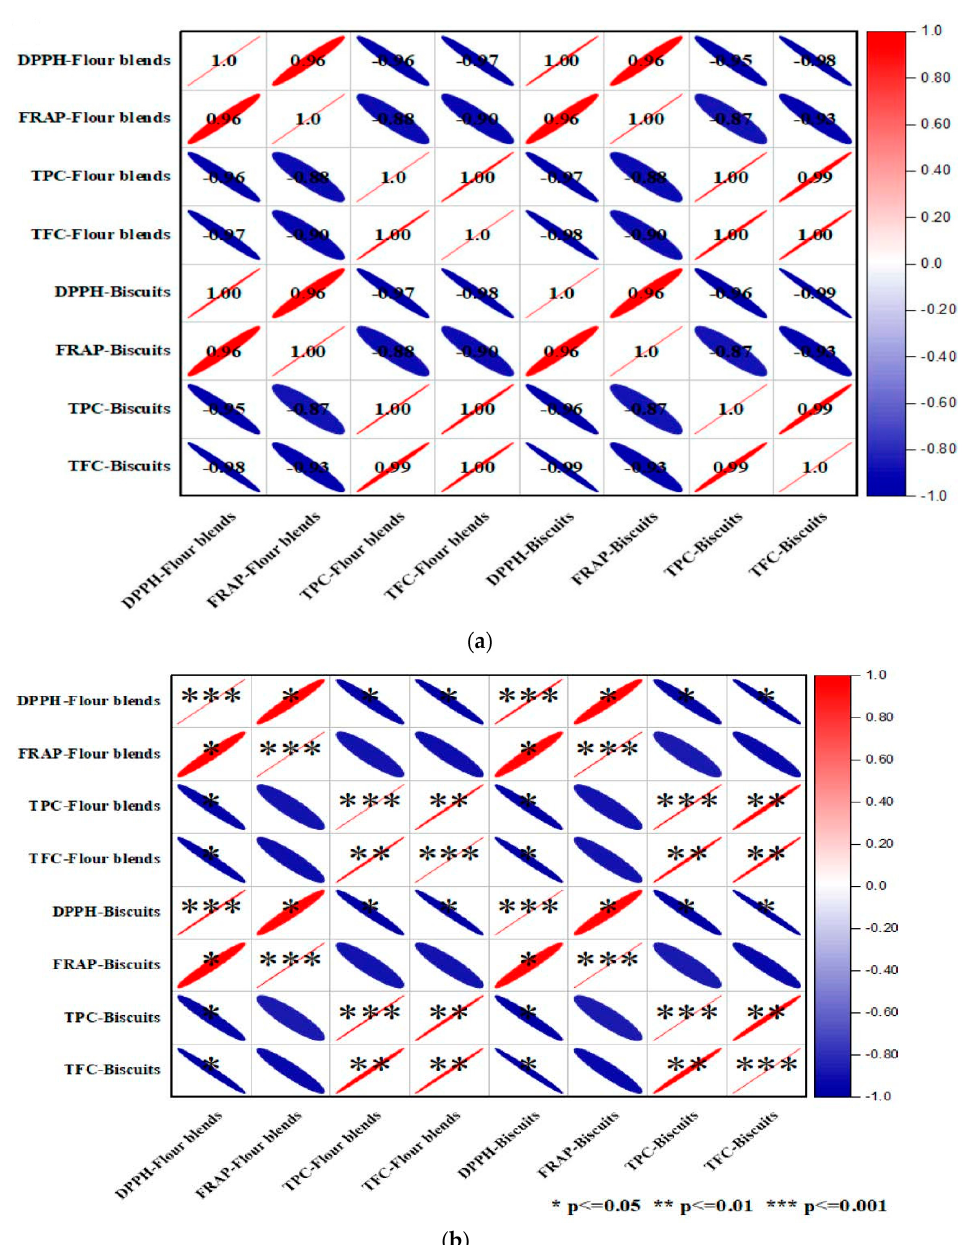
Figure 2. ( a ) Correlogram analysis with the obtained values of the Pearson coefficient of correlation between the bioactive compounds (total phenol content (TPC) and total flavonoid content (TFC)), and antioxidant activities (DPPH-IC 50 and FRAP-IC 50 ) of flour blends and biscuits. ( b ) Correlogram with the defined significance levels, where DPPH: 2, 2-diphenyl-1-picrylhydrazyl, FRAP: ferric reducing antioxidant power.